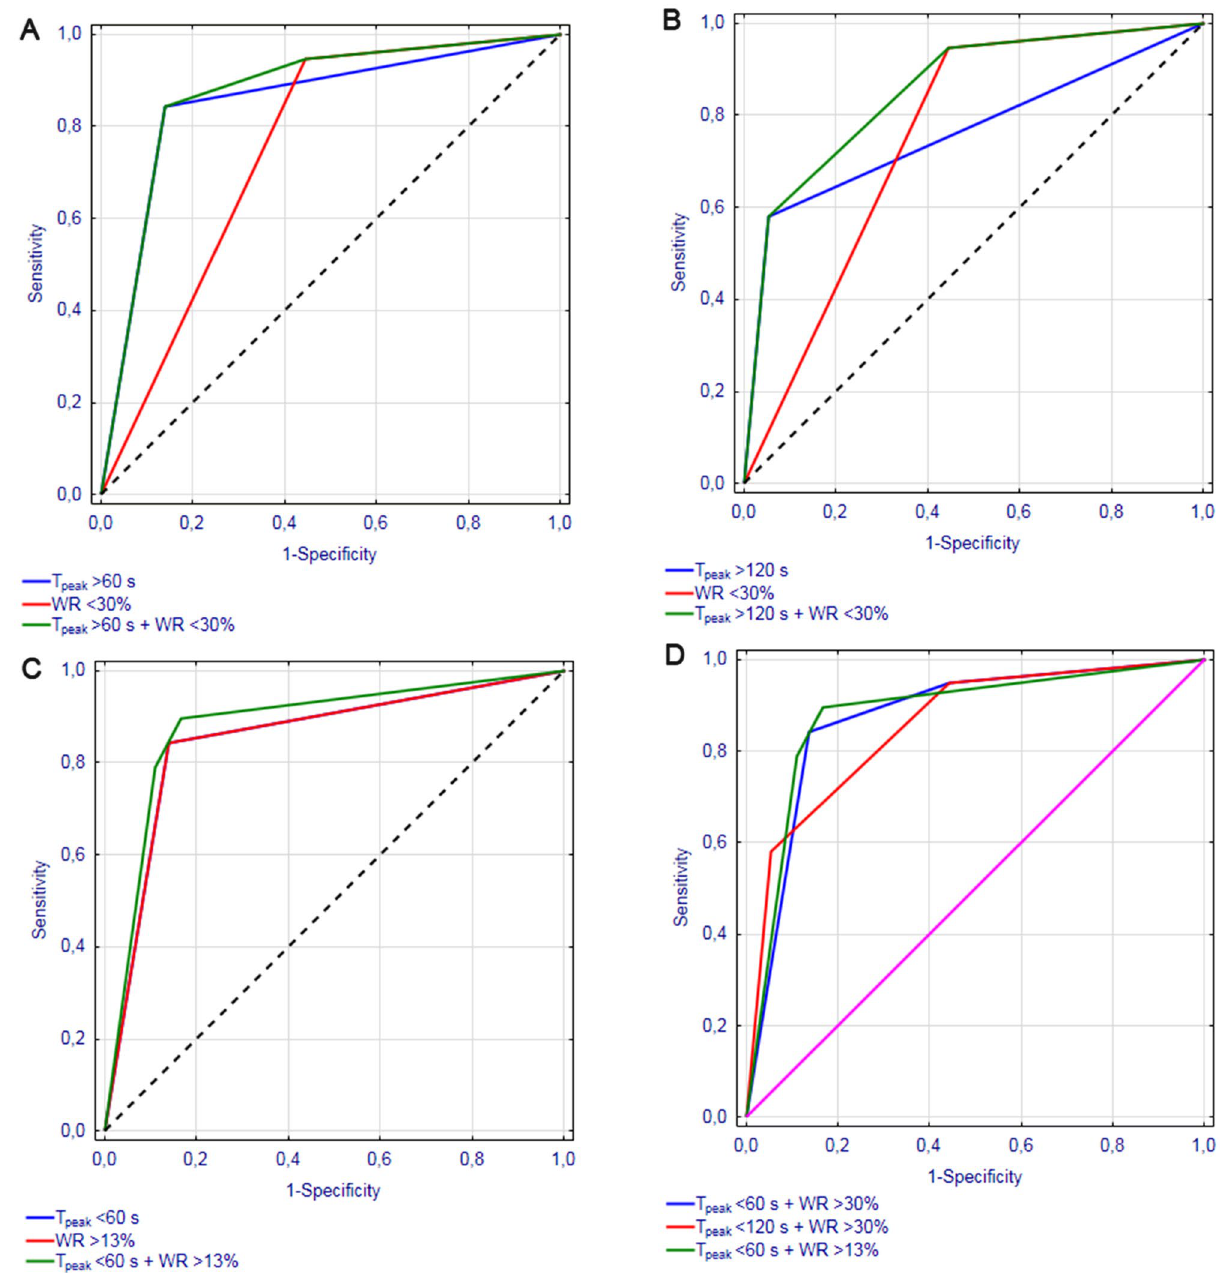
Figure. 1. ROC curves illustrating the accuracy of DCE-MRI with the cut-off values ( A ) T peak > 60 s and/or WR ≤ 30%, ( B ) T peak > 120 s and/or WR ≤ 30%, ( C ) T peak > 60 s and/or WR ≤ 13% in the differential diagnostics of parotid malignancies, and ( D ) comparison of the ROC curves for